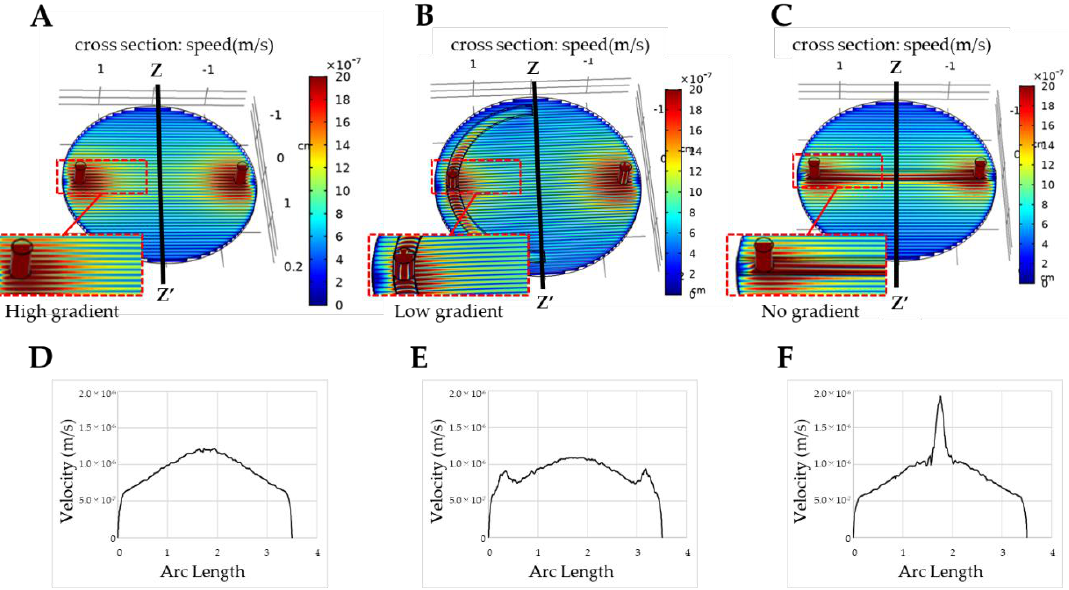
Figure 4. Simulation analysis of liquid flow in a perfusion culture dish with a CD-adapter. Liquid flow in the culture dish at 1.4 µL/min through the inlet was simulated and analyzed using COMSOL. ( A ), adapter without the small recess structure; ( B ), U-shaped structure adapter; ( C ), I-shaped structure adapter. Flow velocity on the Z-Z’ line in ( A – C ) are plotted in ( D – F ), respectively. In ( F ), the liquid flow remarkably increased under the I-shaped groove compared to ( E ).